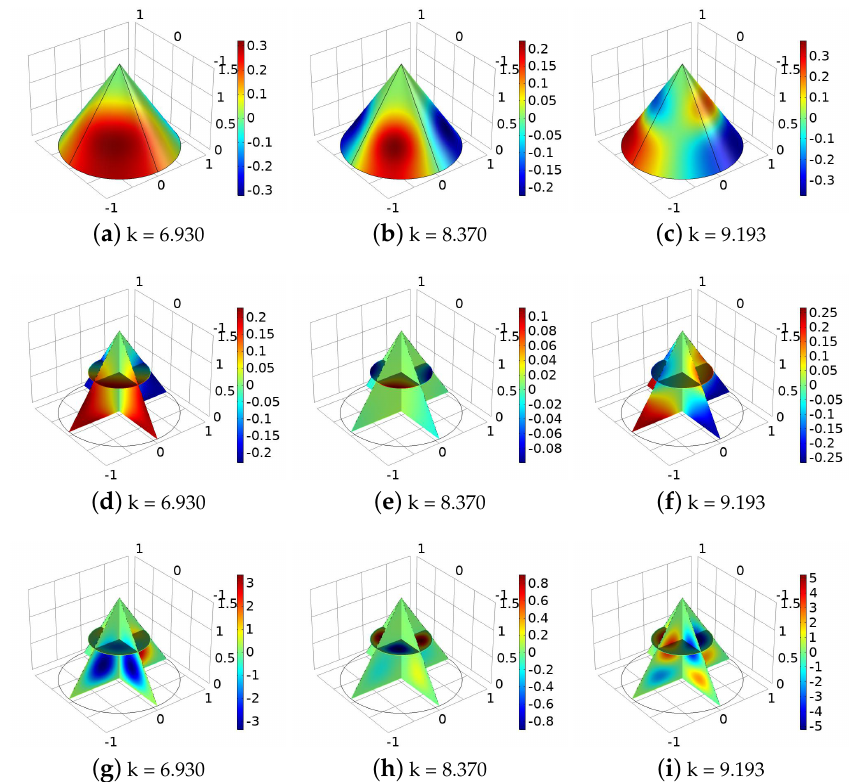
Figure 8. The magnitude of transmission eigenfunctions for a cone with different k ’s. ( a – c ): surface